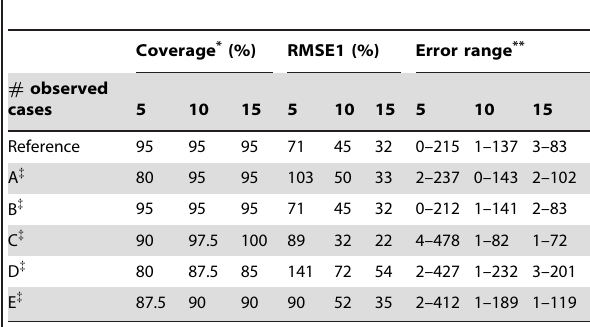
Table 3. Performance of the Back-calculation Method to Fit the Expected Outbreak